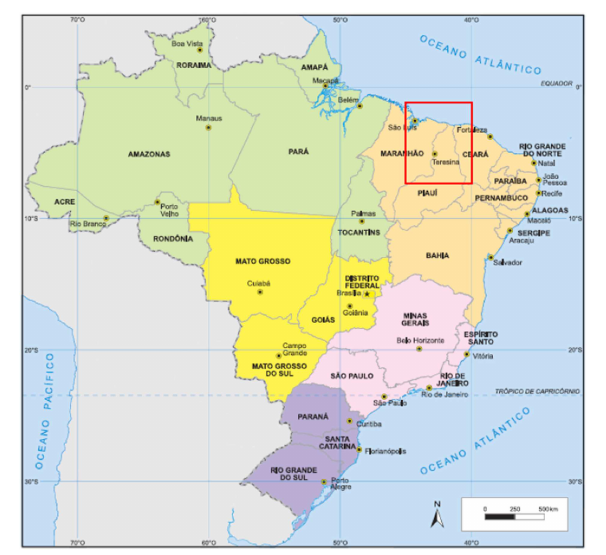
FIGURE 1 | Location of the study region: North of the NEB delimited by the red box between 2 and 7 ◦ S; 40 and 45 ◦ W. The location is similar as in Silva and Mendes (2013). Adapted from http://mapas.ibge.gov.br.